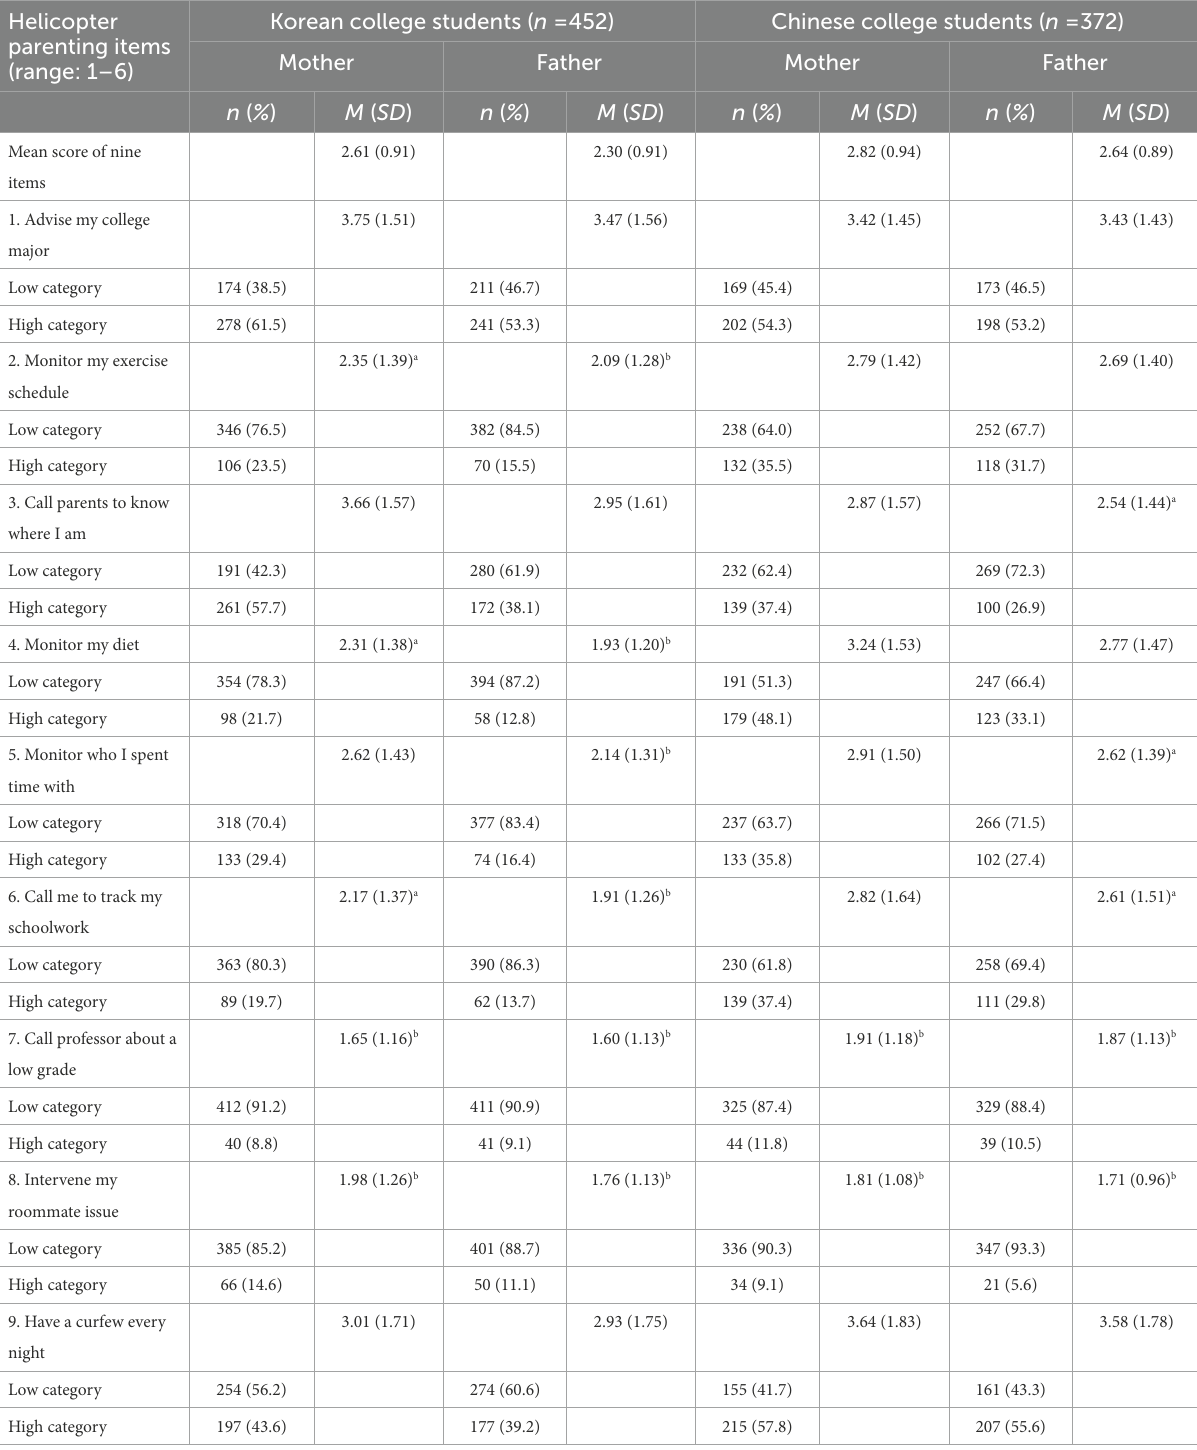
TABLE 1 Descriptive results of maternal and paternal helicopter parenting in Korean and Chinese college students. Helicopter parenting